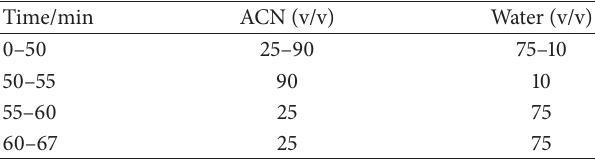
Table 2: Elution gradient used in the HPLC